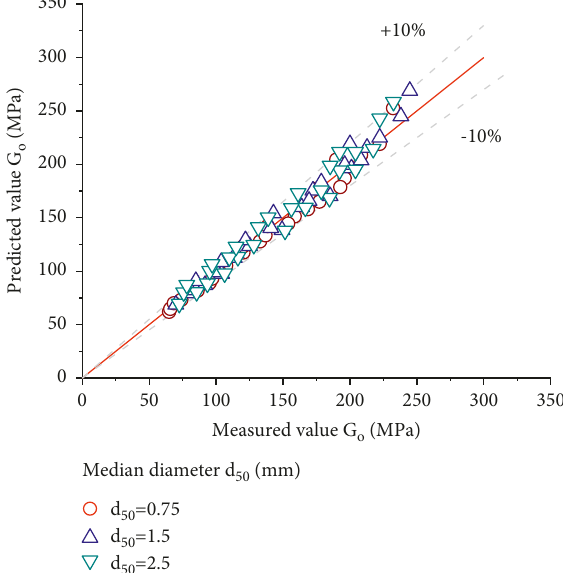
Figure 16: Measured and predicted maximum shear modulus G of the calcareous sand using the proposed estimated